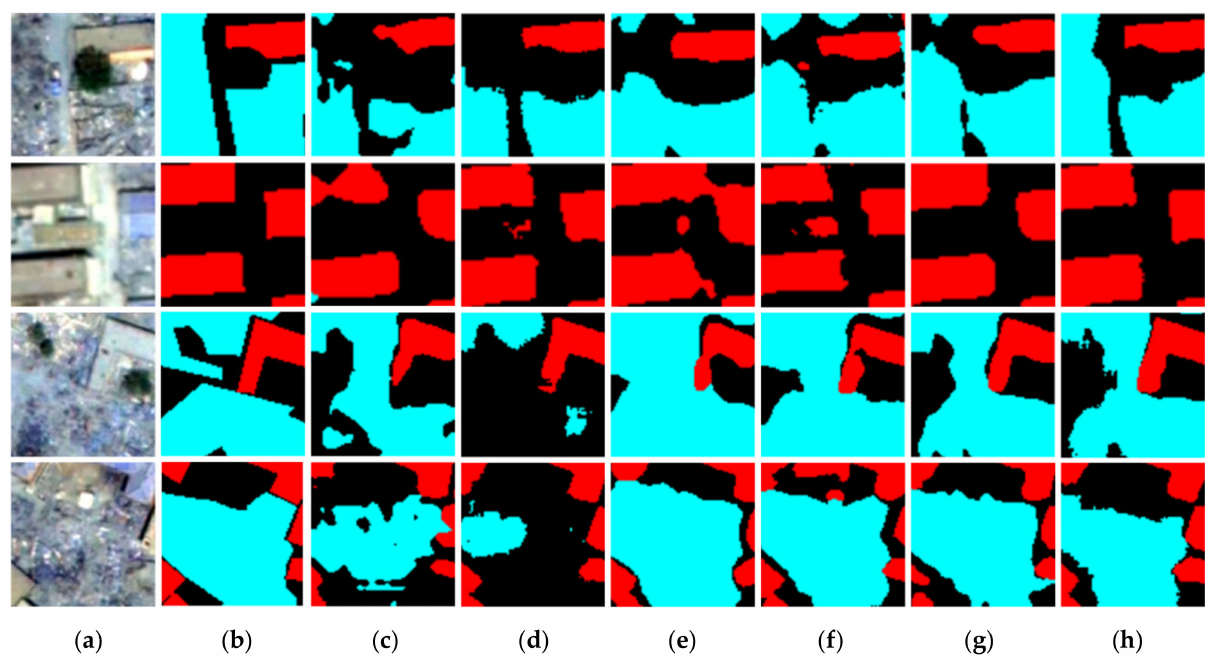
Figure 10. Partially enlarged images of the detection results of the YSH dataset by different networks: ( a ) original image; ( b ) ground truth map; ( c ) DeepLabv3+; ( d ) UNet; ( e ) MobileNetV2+CA; ( f ) UNet 3+; ( g ) OB-DeepLabv3+; ( h ) OB-UNet; red, blue and black in ( b – h ) represent the non-collapsed buildings, collapsed buildings and the